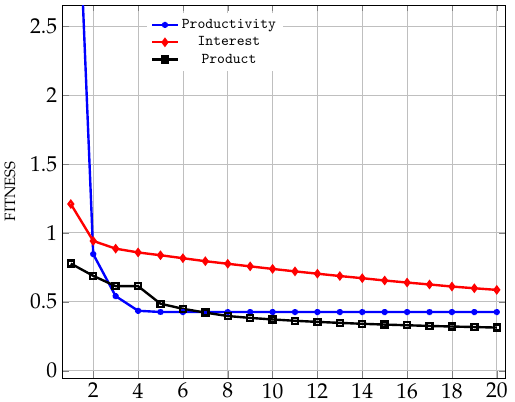
Figure 4. Evolution of the fitness for three applications: Productivity , each 0.01 s, Interest , each 1.5 s and Product , each 25